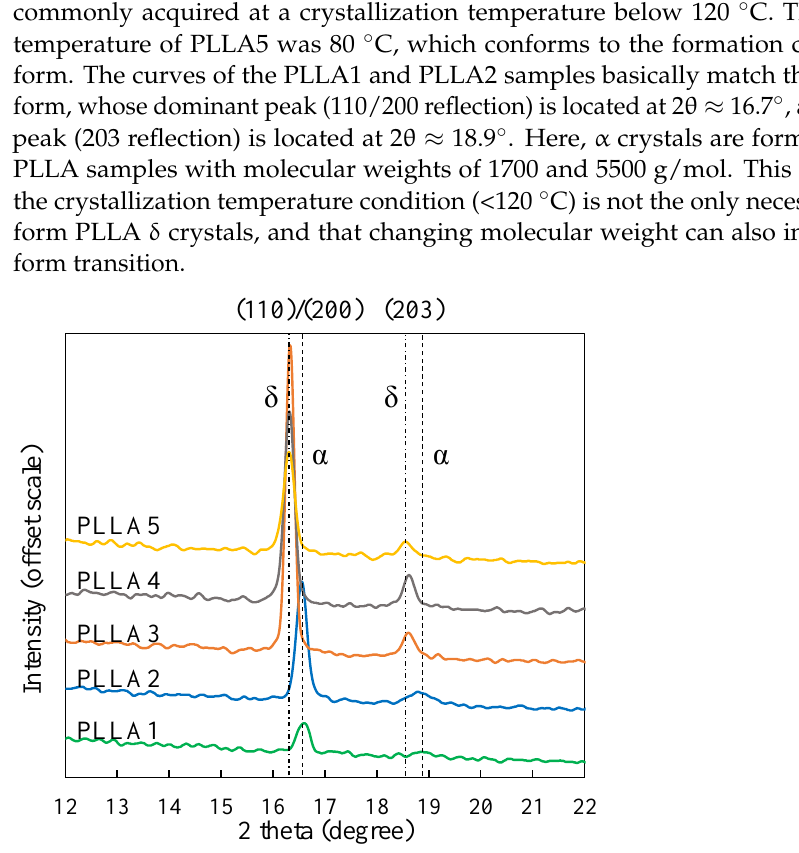
Figure 3. WAXD diffraction profiles of five PLLAs after crystallization treatment at a temperature of 80 °C.